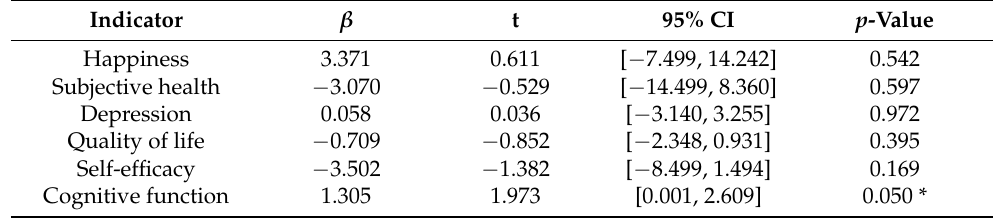
Table 4. Results of difference-in-differences regression analysis of the effects of digital literacy